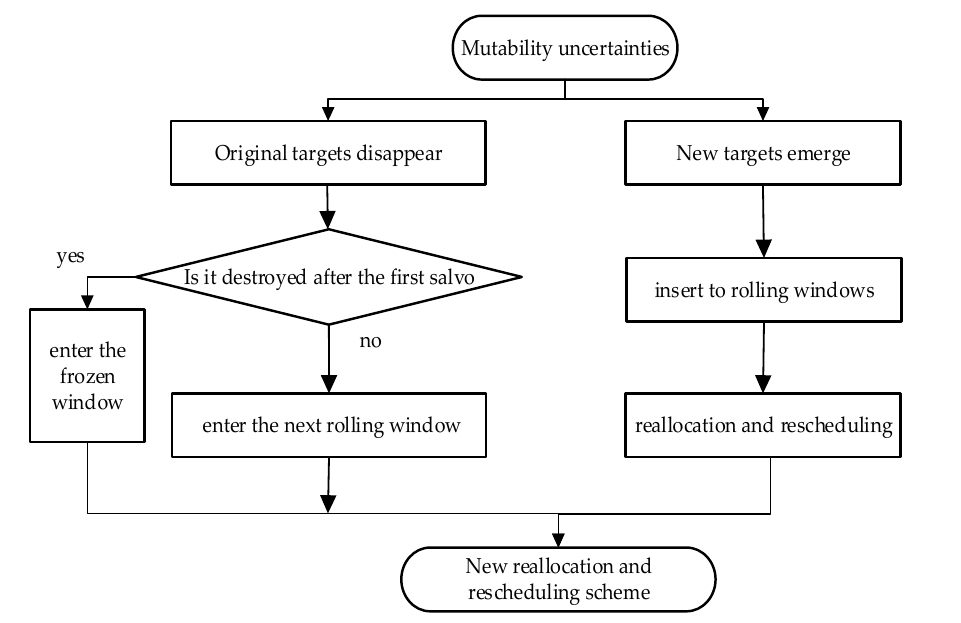
Figure 4. Flowchart of reallocation and rescheduling strategy based on marginal benefits.